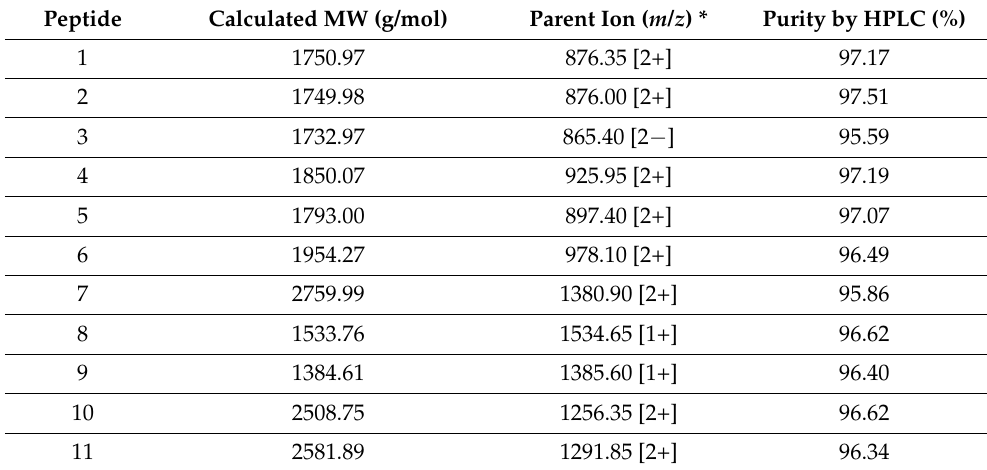
Table 5. Parent ion for each synthetic peptide, calculated molecular weight, and purity. Peptide Calculated MW (g/mol) Parent Ion ( m / z ) * Purity by HPLC